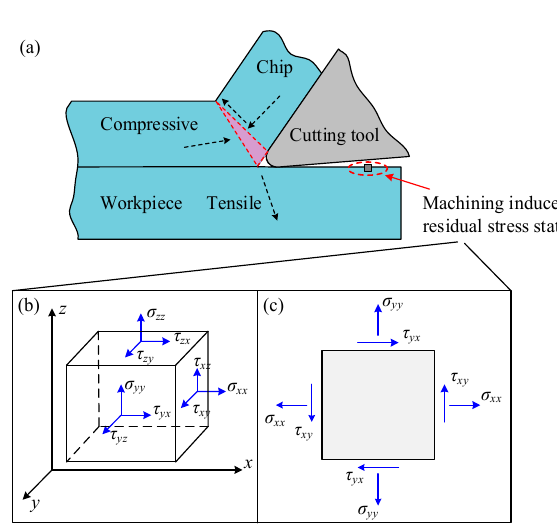
Figure 1. ( a ) Residual stress generation during machining, ( b ) space stress state, and ( c ) plane stress state.